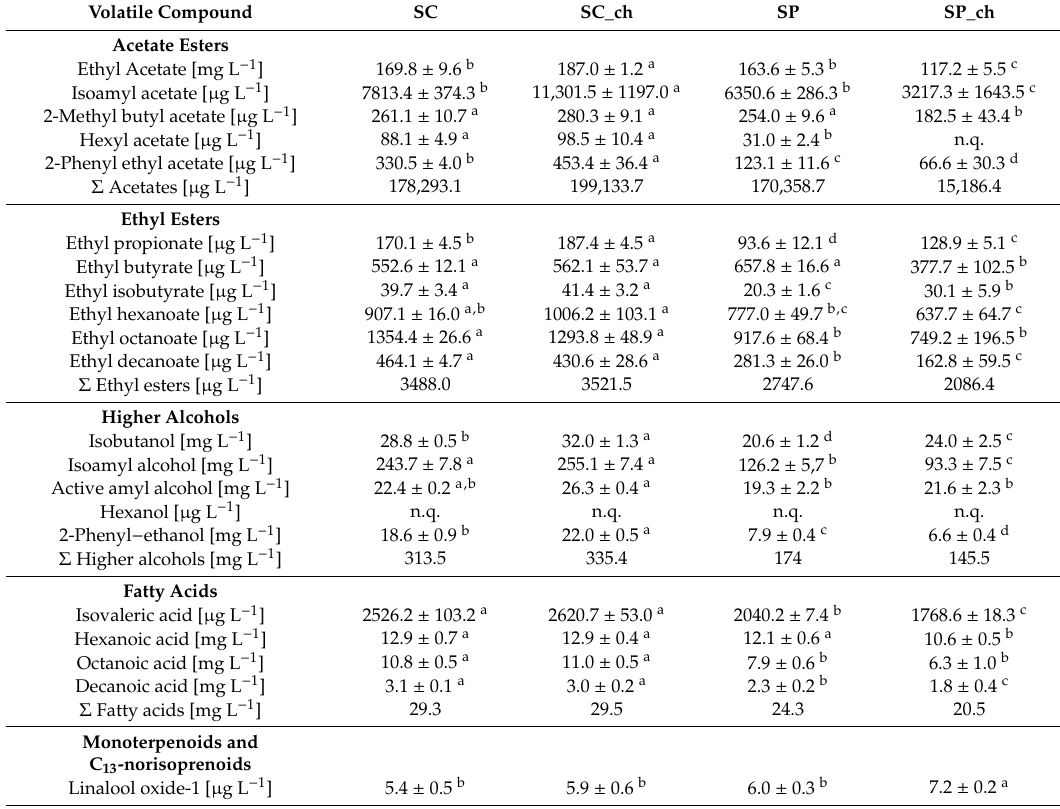
Table 2. Volatile compounds measured after the fermentation of Sac. cerevisiae (SC), Sac. cerevisiae fermenting with chitosan (SC_ch), Sch. pombe (SP), and Sch. pombe fermenting with chitosan (SP_ch). Volatile Compound